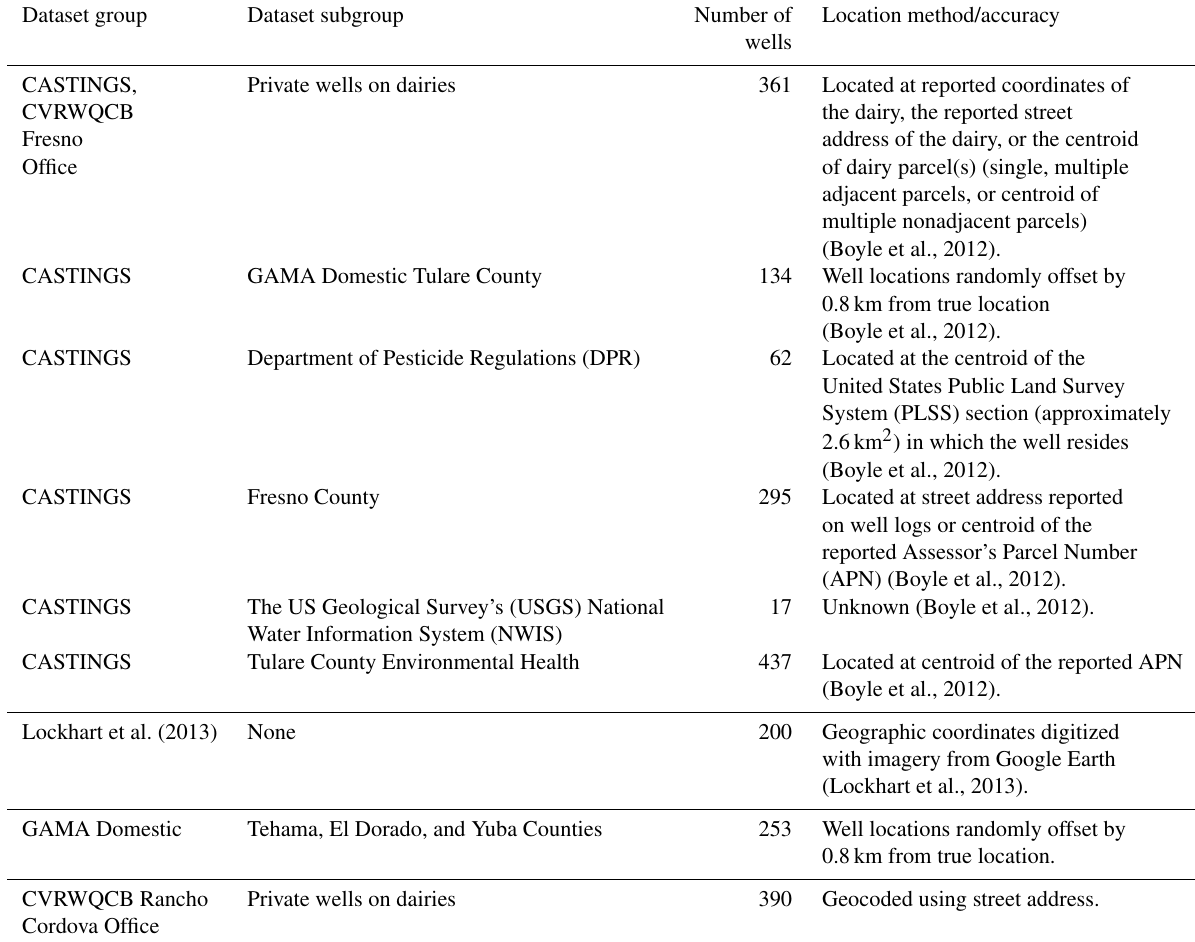
Table 1. Original data source, number of wells, and well location method for private wells included in final database (2149 wells